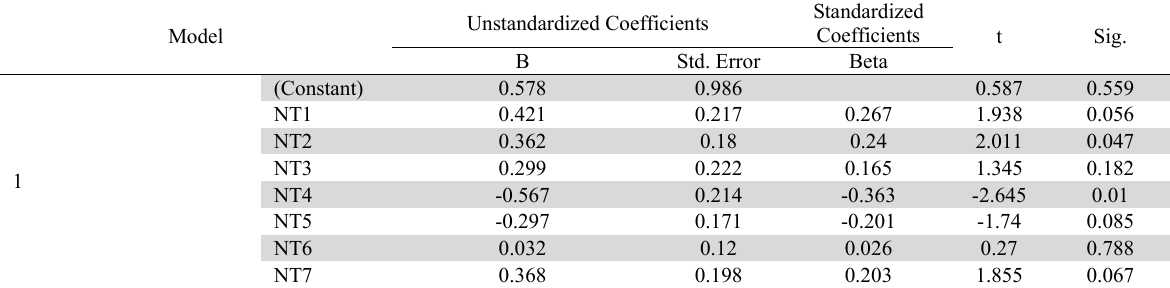
Unstandardized Coefficients